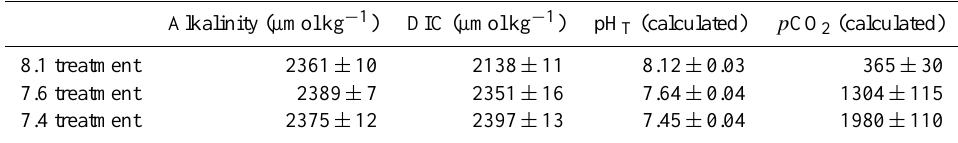
Table 2. Average values ( ± SD, n = 6) for A T and DIC (measured) and pH T and p CO 2 (calculated) recorded over a 90-day period in three pH T treatments during the culture of Z. subcarinatus .